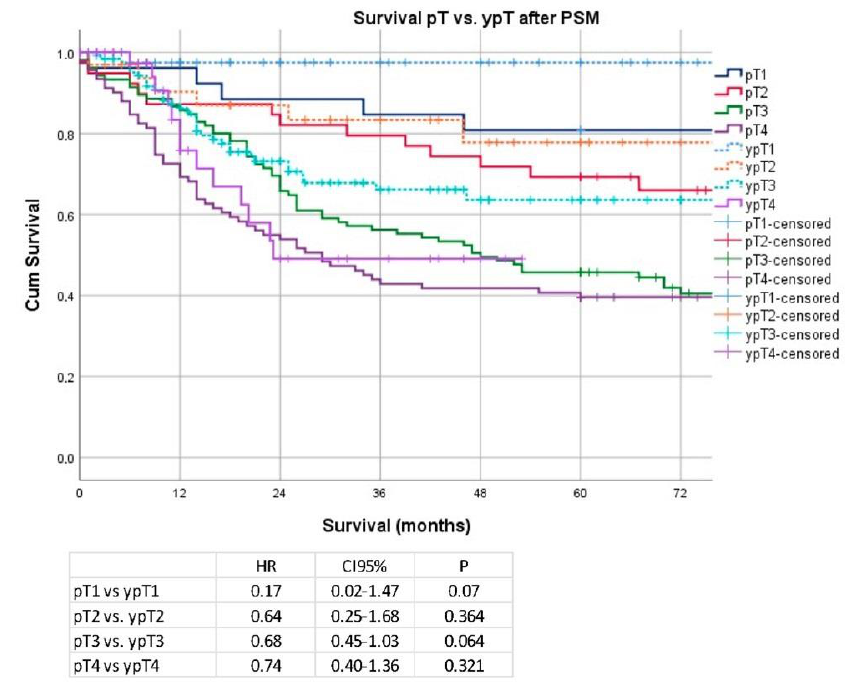
Figure 5. Kaplan – Meier analyses according to pT/ypT stages after PSM. Figure 5. Kaplan–Meier analyses according to pT/ypT stages after PSM.